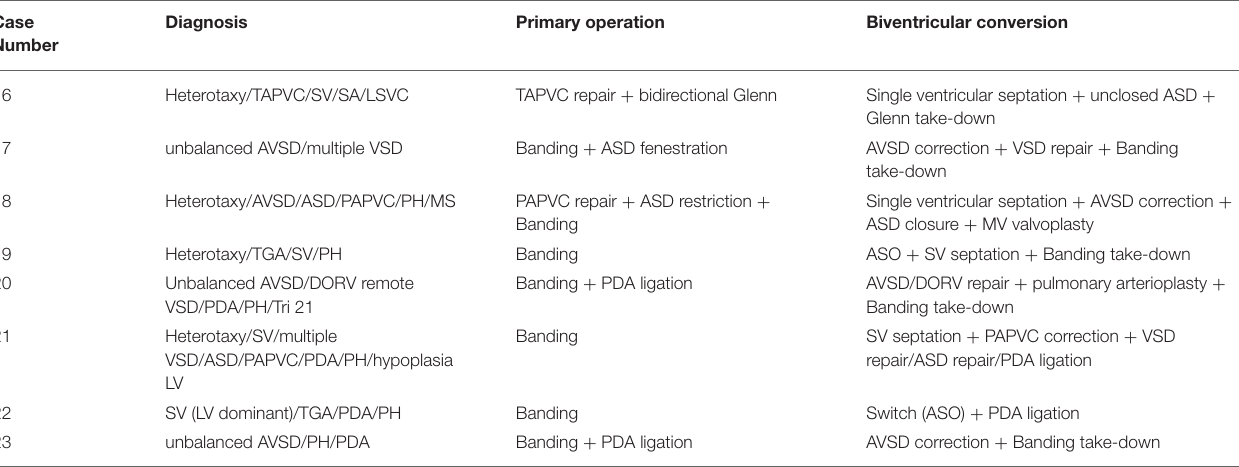
TABLE 4 | Operative data of each case receiving biventricular conversion in the imbalanced ventricular group. Case